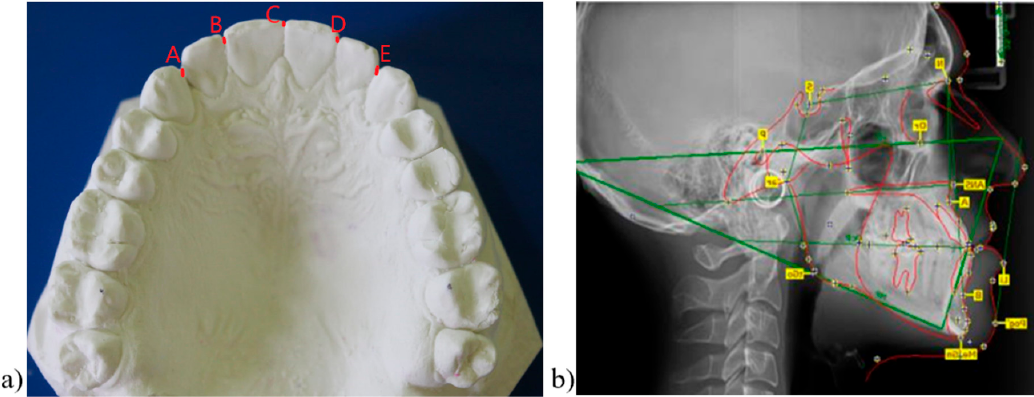
Figure 1. ( a ) Dental cast measurements: Irregularity index (A + B + C + D + E); ( b ) Cephalometric analysis using OnixCeph software.